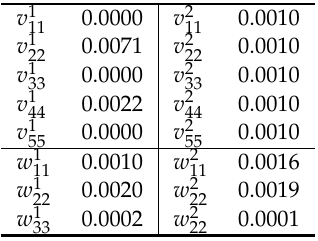
Table 5. ICE U.K. futures: parameters of the diagonal correlation matrices.